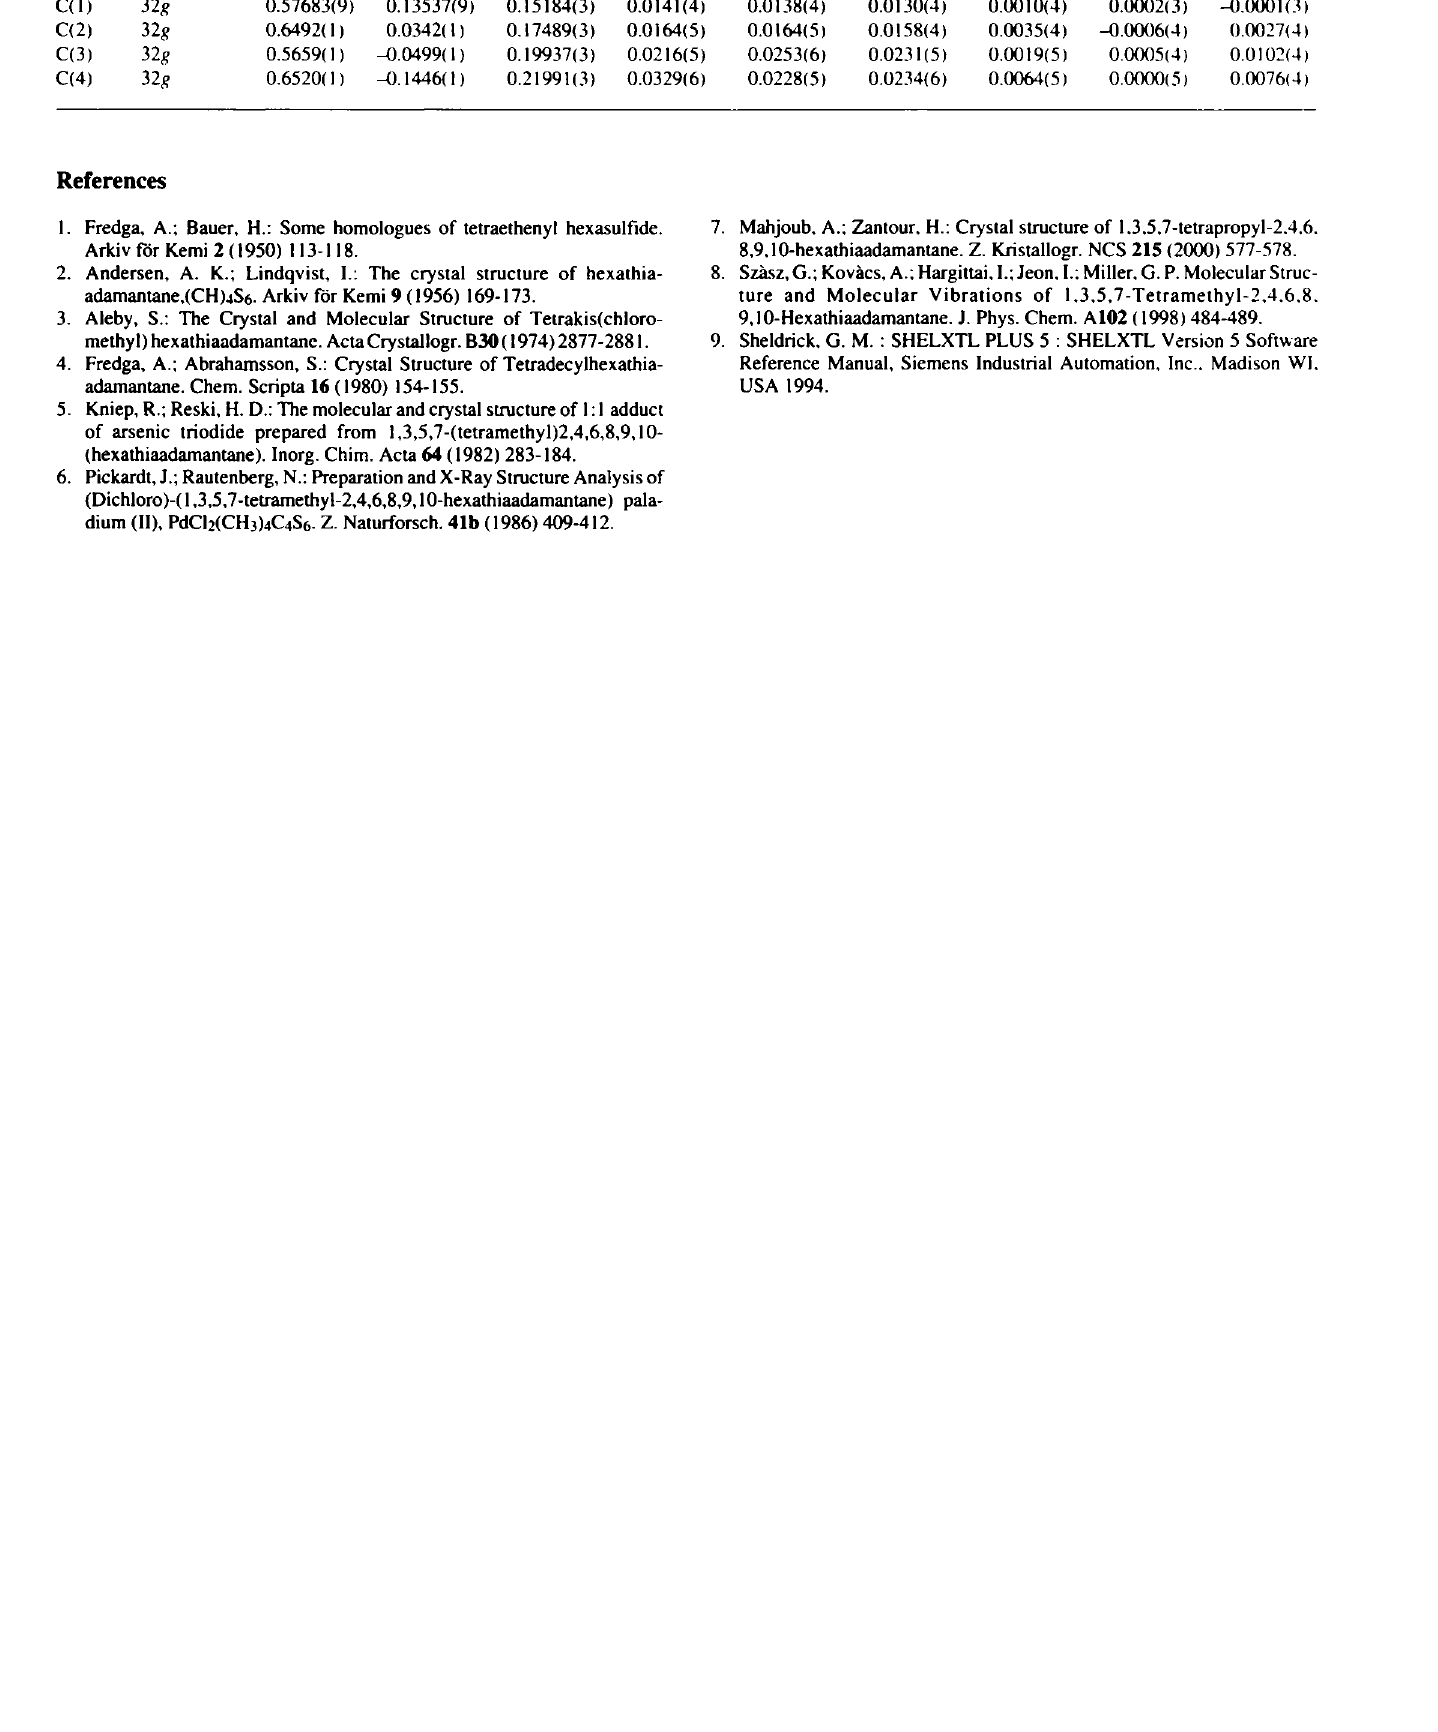
Table 3. Atomic coordinates and displacement parameters (in A 2